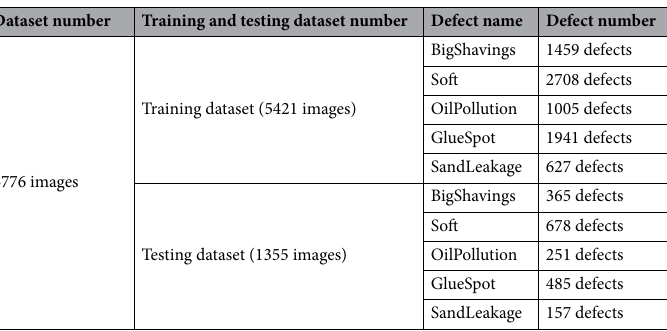
Table 2. Dataset information of particleboard surface